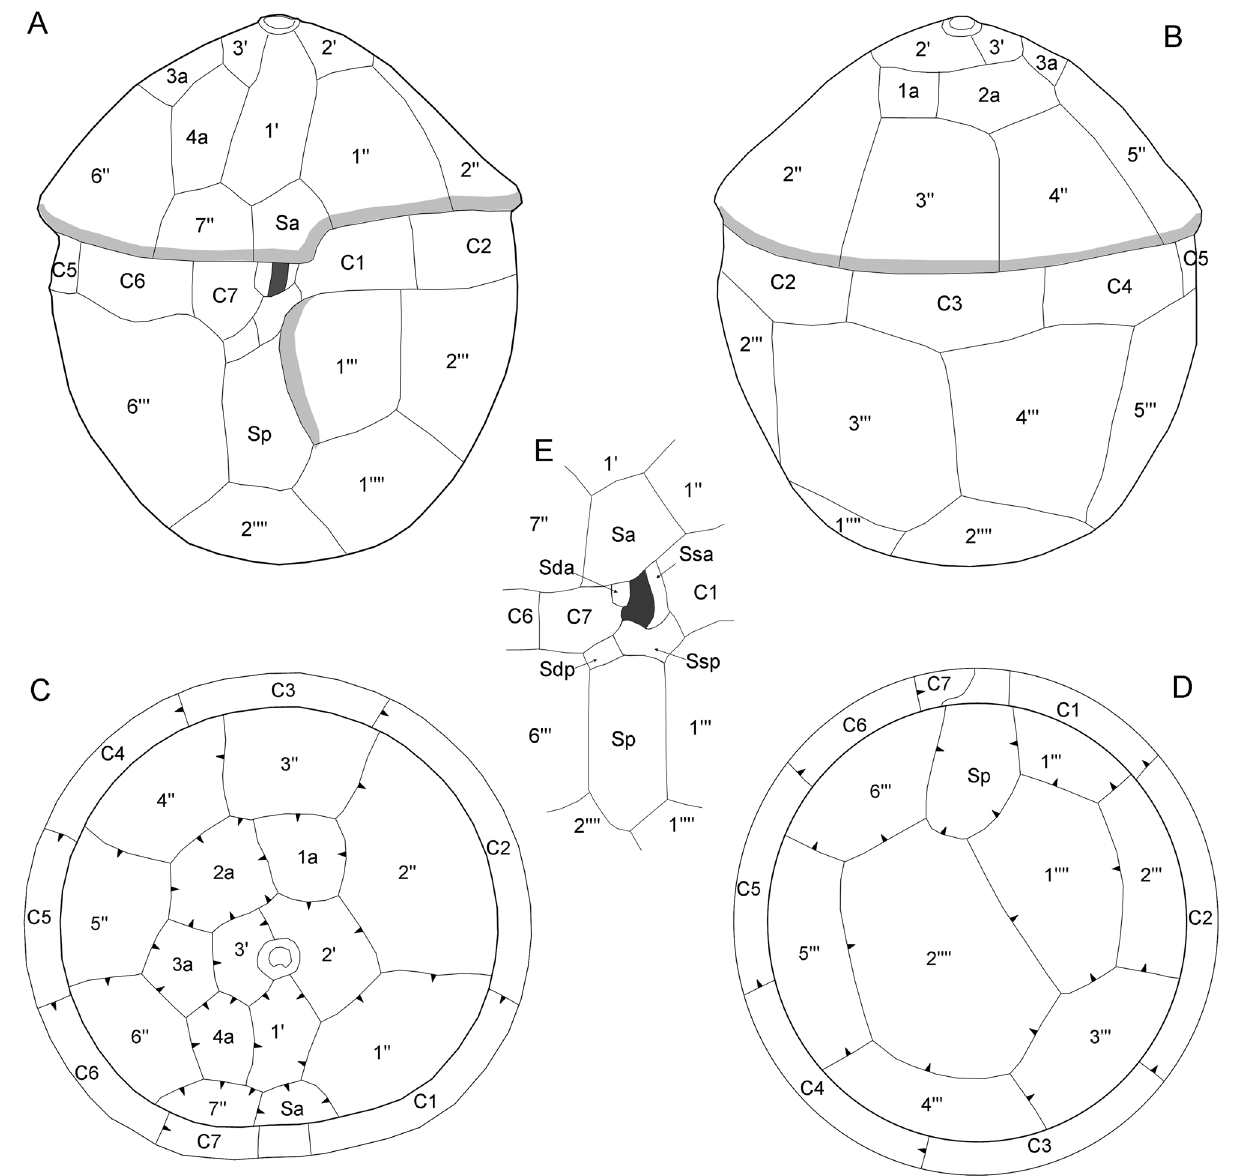
Figure 3. Schematic thecal plate pattern of Fensomea setacea , gen. & sp. nov. ( A ) Ventral, ( B ) dorsal, ( C ) apical, and ( D ) antapical views, and ( E ) details of the sulcal area. Plate labels according to the Kofoidean system. The grey-shading in ( A ) and ( B ) denote cingular and sulcal lists. The dark shading in the central part in ( A ) and ( E ) denote the presumed area from which both flagella emerge. The arrowheads in ( C ) and ( D ) indicate the direction of plate overlap. Abbreviation of sulcal plates: Sa anterior sulcal, Sda right anterior sulcal, Sdp right posterior sulcal, Sp posterior sulcal, Ssa left anterior sulcal, Ssp left posterior